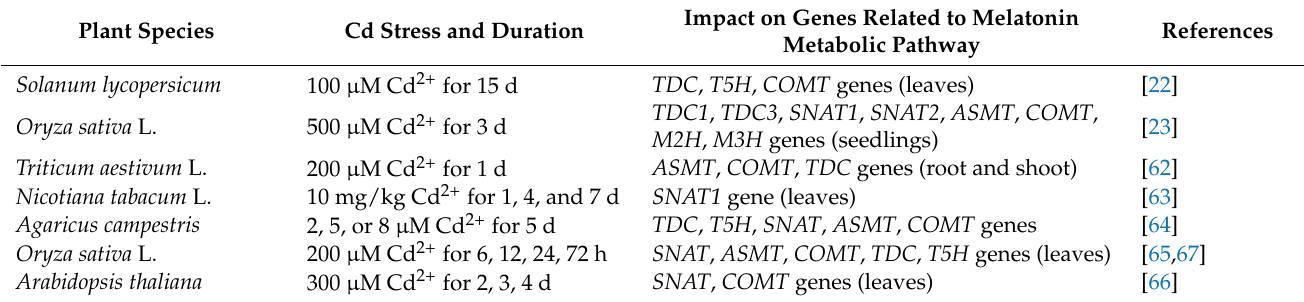
Table 1. Summary table explaining the effect of Cd on genes related to melatonin metabolic pathway. Plant Species Cd Stress and Duration